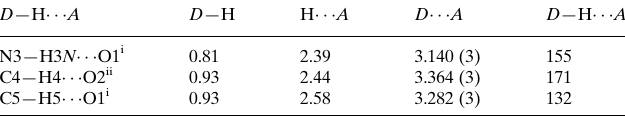
Hydrogen-bond geometry (A˚ , (cid:3)